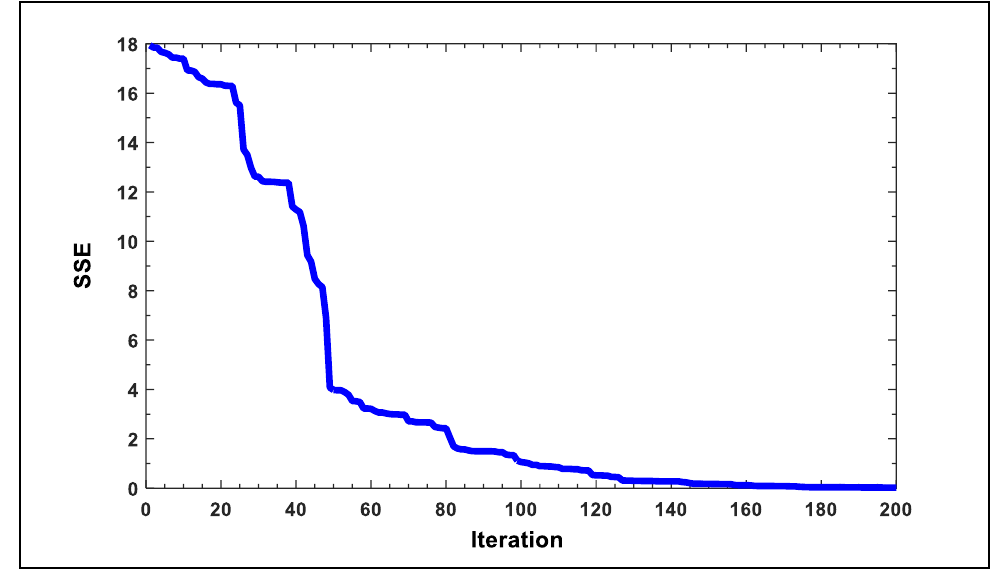
Figure 10. Performance of RBFNN based on PPA in terms of SSE. Table 3. Neural network parameters.